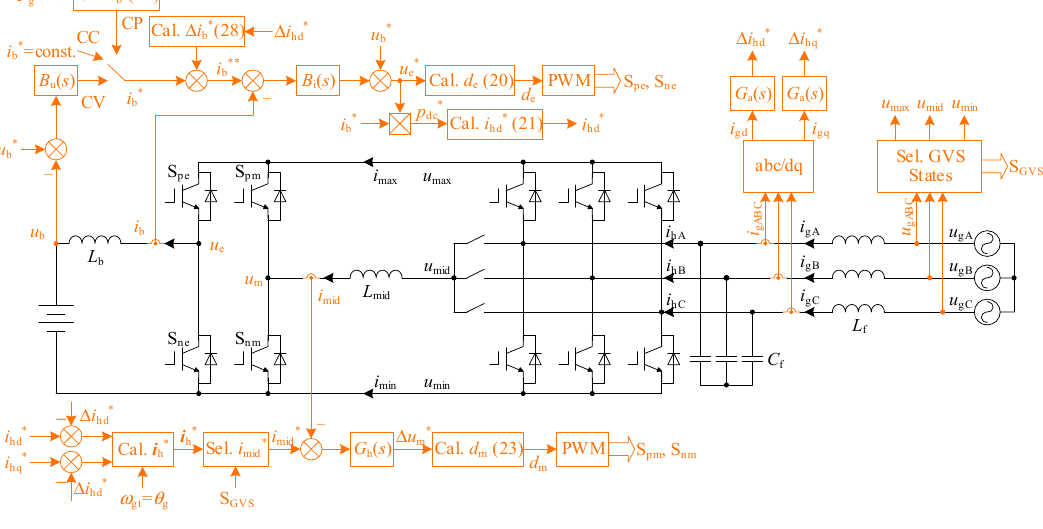
Figure 4. Control block diagram of the H3C-BESS.